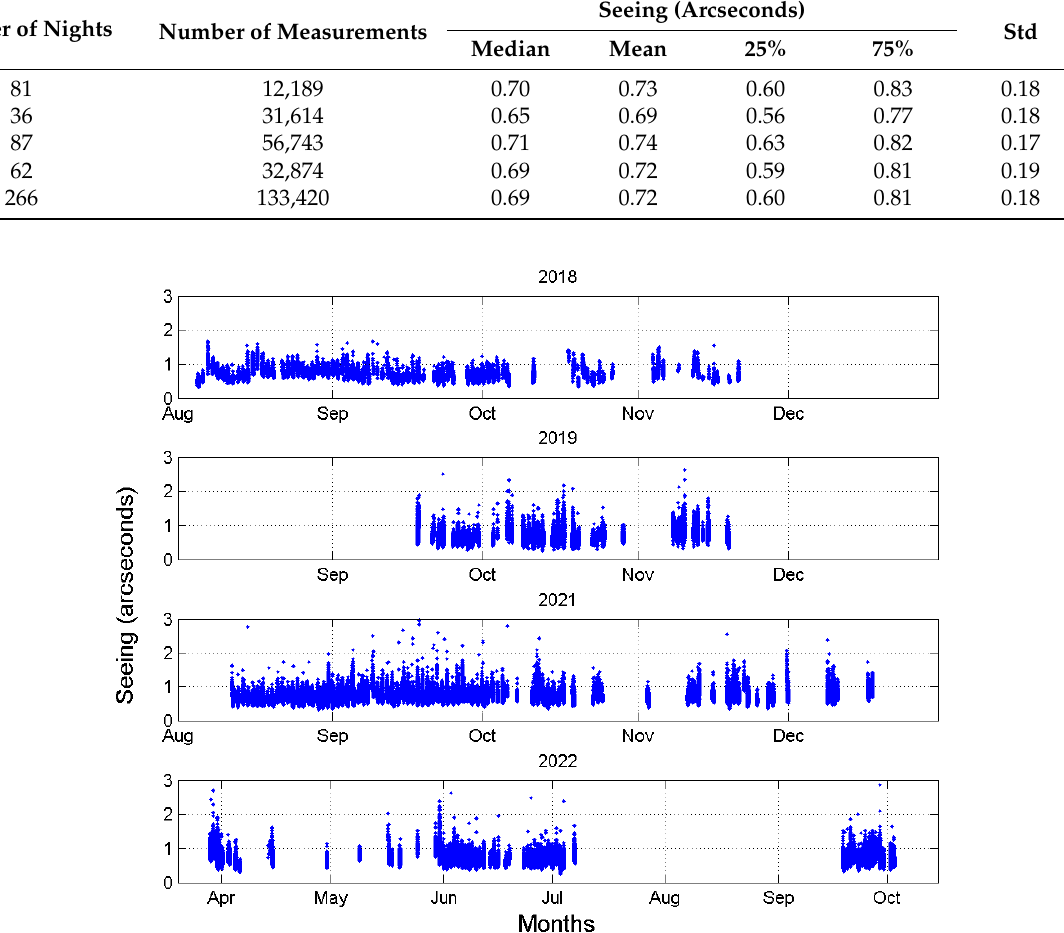
5 of 11 Figure 3. DIMM equipment and weather station.